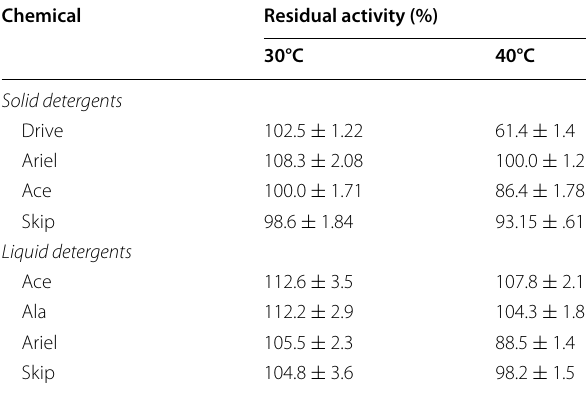
Table 3 Stability and compatibility of keratinase in presence of different commercial detergents. Values are the mean of three replicates standard deviation. 100% of activity corresponds ± to those displayed by the enzyme without the presence of any detergent